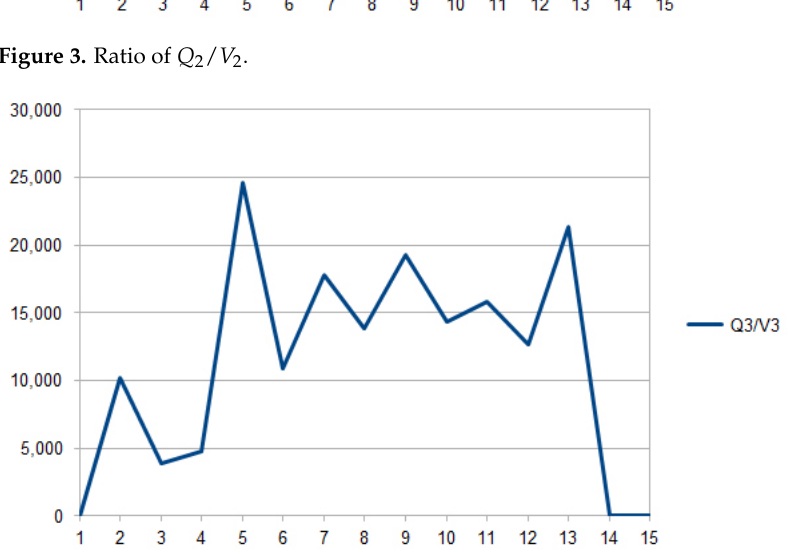
Figure 3. Ratio of Q 2 / V 2 .